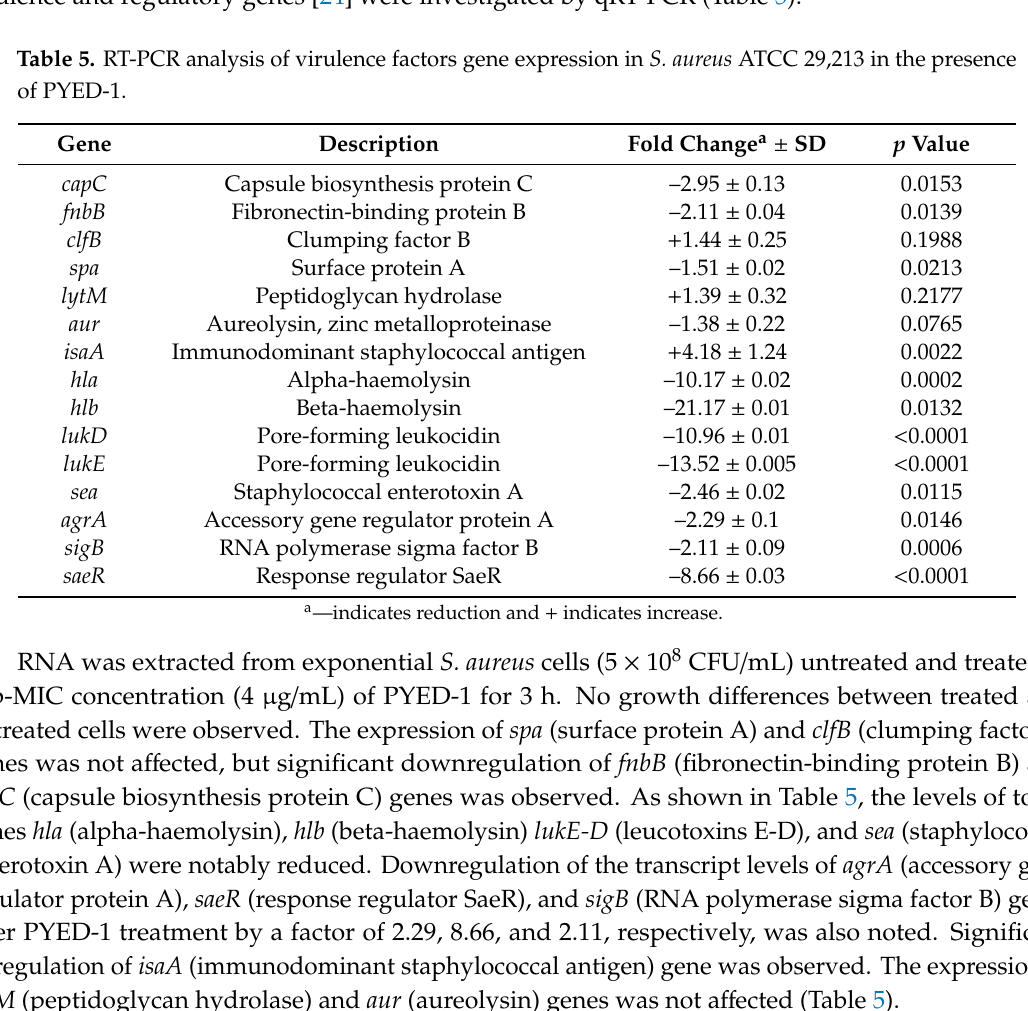
Table 5. RT-PCR analysis of virulence factors gene expression in S. aureus ATCC 29,213 in the presence of PYED-1.